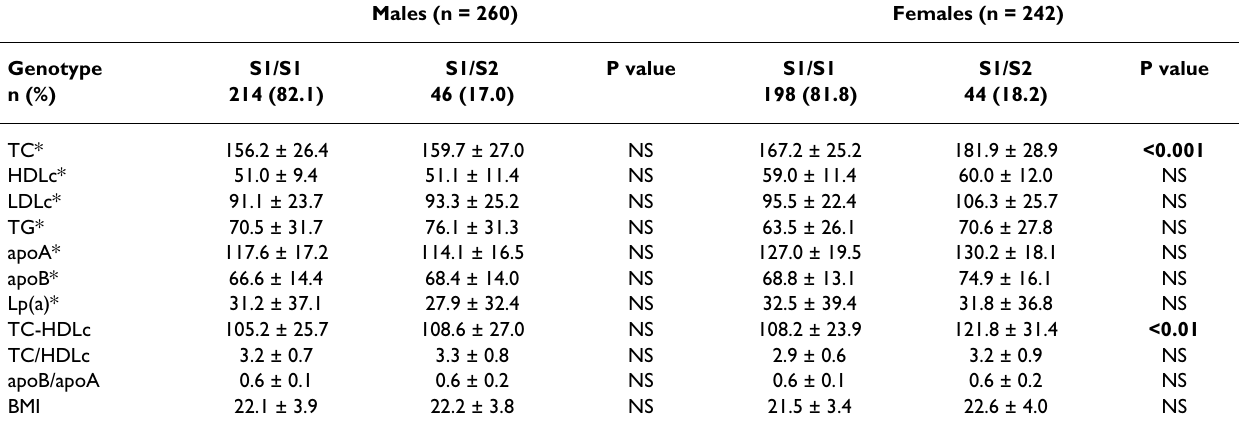
Table 4: Lipid and lipoprotein levels (mg/dl) and body mass index (kg/m 2 ) according to the APOC3 genotypes and sex Males (n = 260) Females (n = 242)